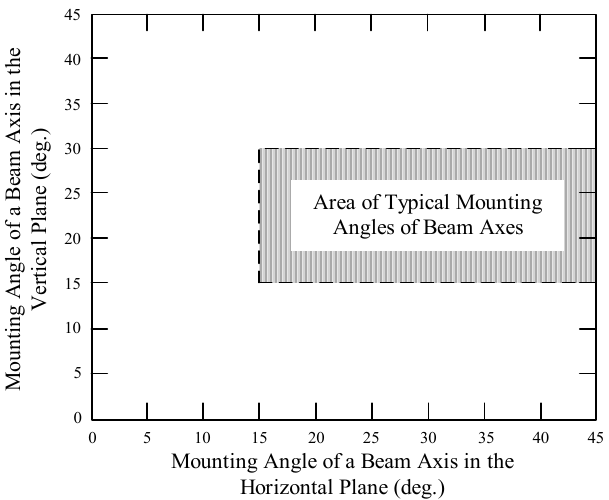
Figure 2. Area of typical mounting angles of the Doppler navigation system (DNS) beams.